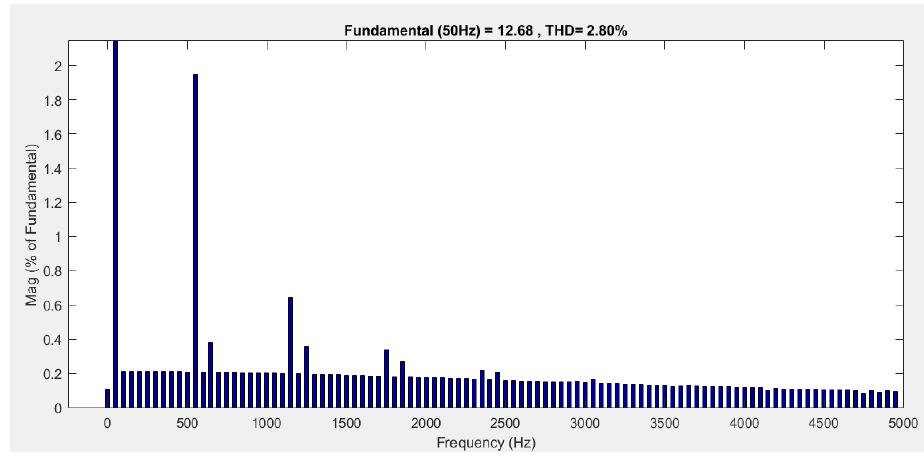
Figure 9. Spectral analysis of the grid current ( i L1 ) drawn by the rectifier with the current modulator (the current modulator is based on the H-bridge with the output filter).